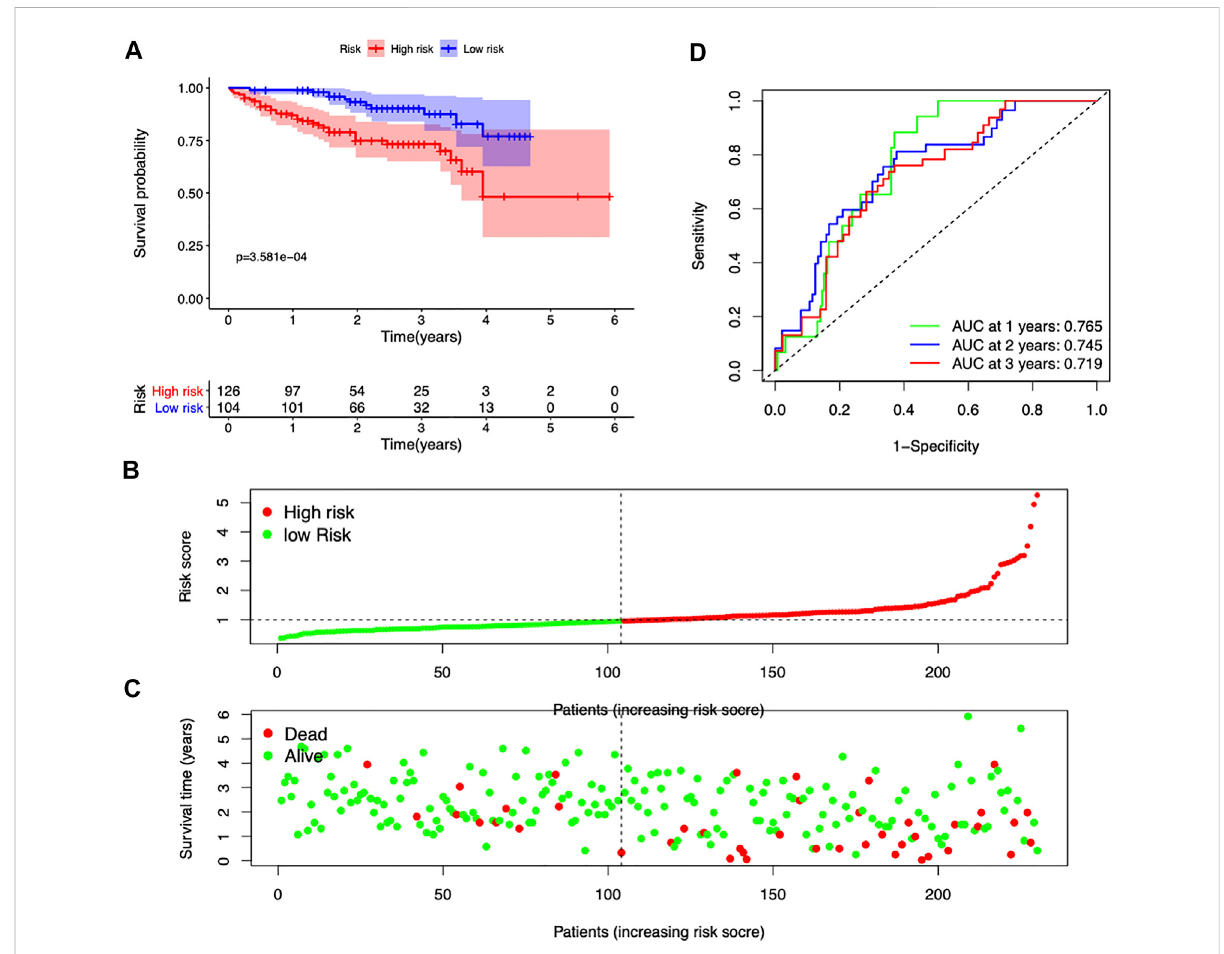
FIGURE 3 Validation of theseven-generisk model in theICGC dataset. (A) Survival curves strati fi edby therisk score in theICGC cohort. (B,C) Distribution of risk score, survival time, and survival statuses in the ICGC cohort. (D) ROC curves of risk model for predicting survival in the ICGC